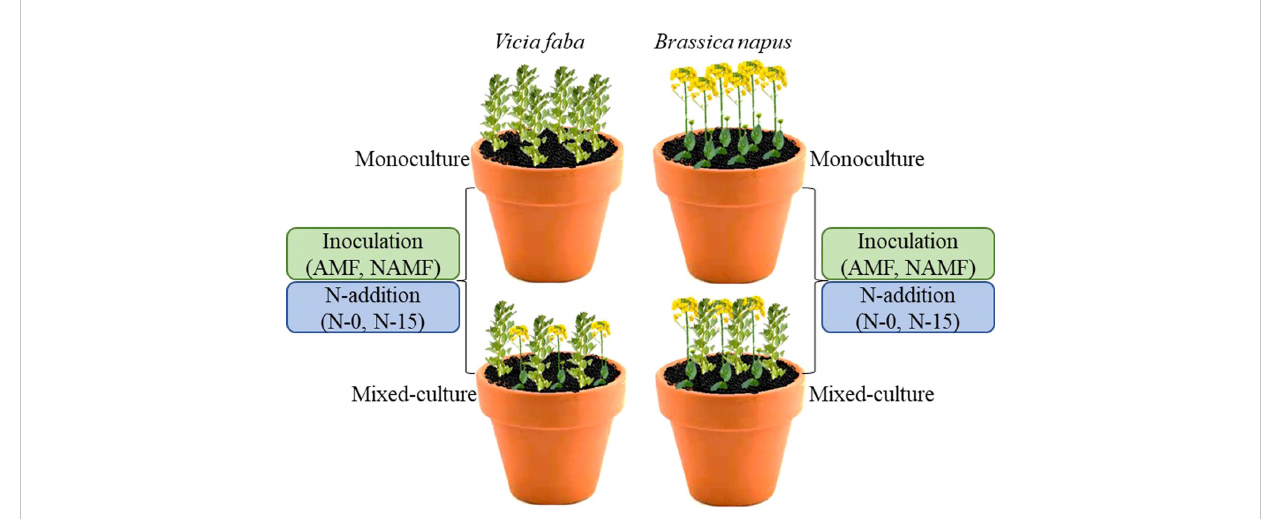
FIGURE 1 In monoculture and mixed-culture V. faba and ( B ) napus under AMF inoculation and N-addition conditions of N-0 and N-15 were imposed for both harvests (Day 45 1 st harvest and Day 90 2 nd